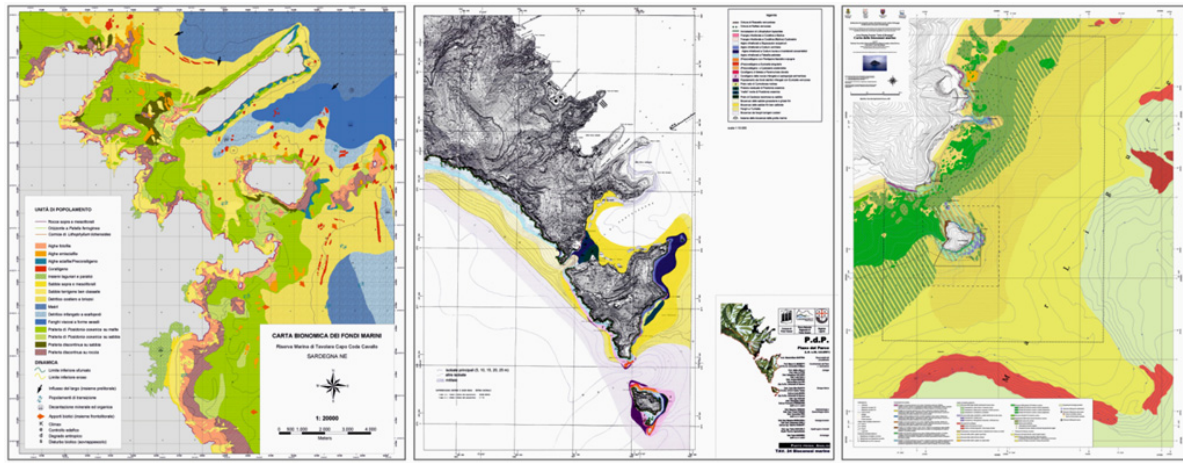
Figure 3. Reproduction at reduced scale of the marine habitats maps of the three MPAs considered. Left to right: “Tavolara-Punta Coda Cavallo” (original scale 1:25,000), “Arcipelago di Portovenere” (original scale 1:10,000), “Isola di Bergeggi” (original scale 1:2,000). These maps, at their full size, can be freely downloaded from the SEAMap site